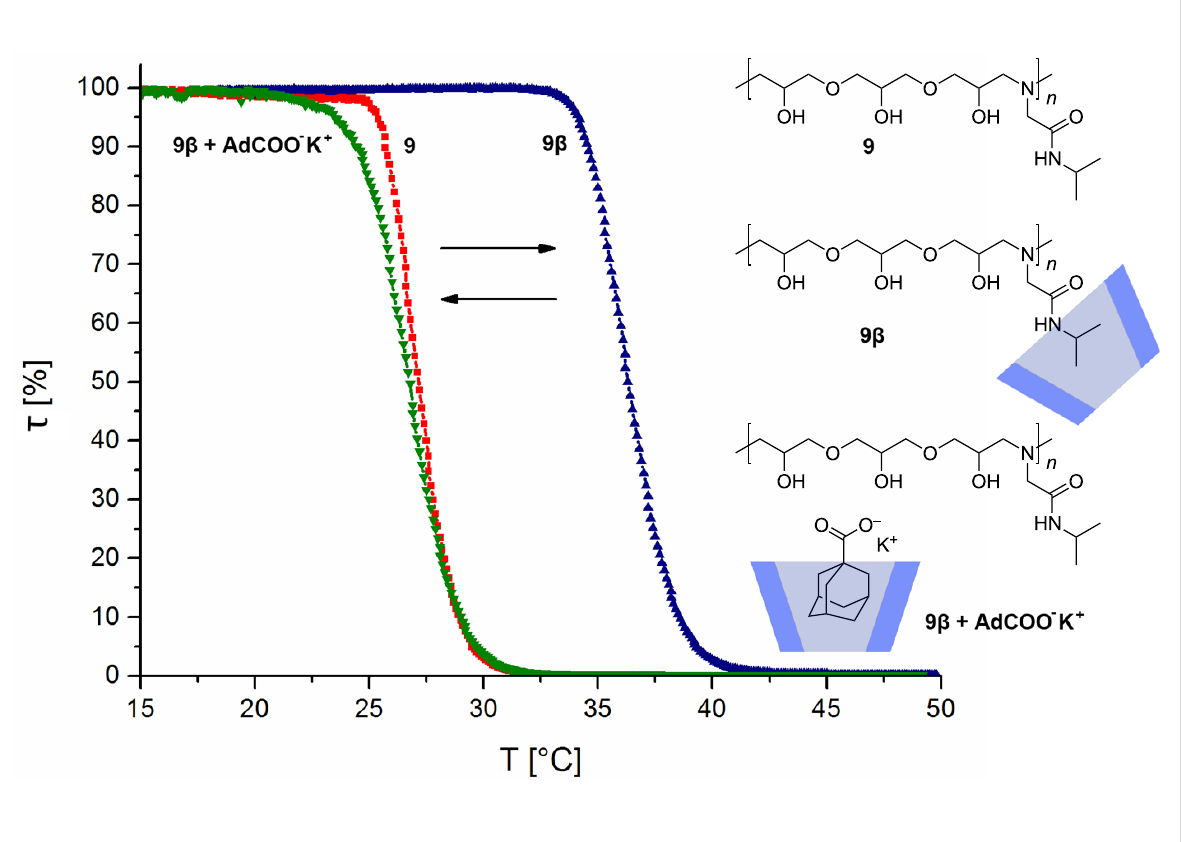
Figure 1: Heating curves of the LCST measurements of 9 , the complex of 9 with RAMEB-CD 9 β , and of 9 with RAMEB-CD with added AdCOO − K + .